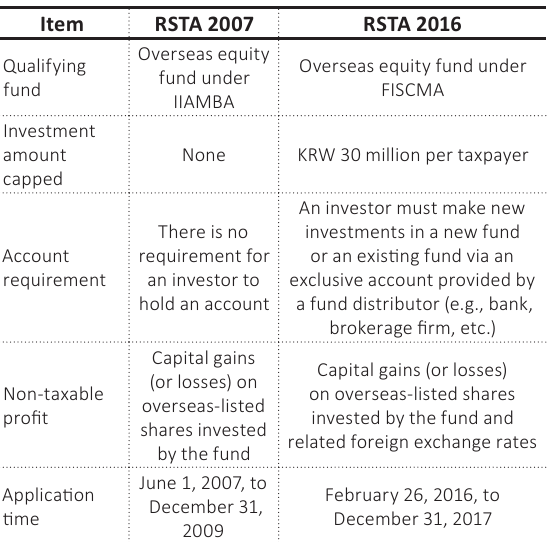
Table 1. Comparison of RSTA 2007 and RSTA